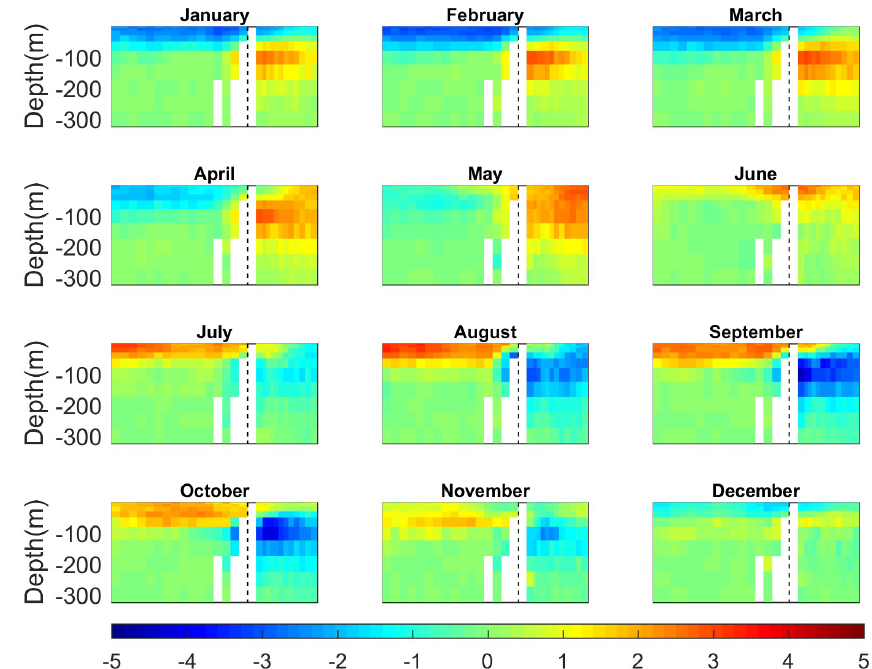
Figure 13. Monthly climatology of temperature anomalies along the section depicted in Fig. 11a, with a zoomed-in view in the 0–300m